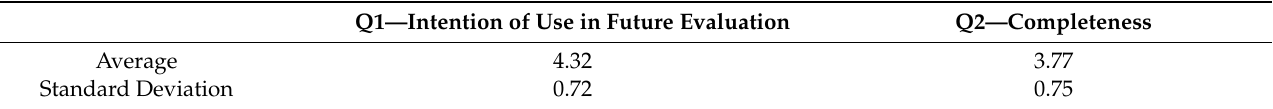
Table 2. Planning Stage Specification. Q1—Intention of Use in Future